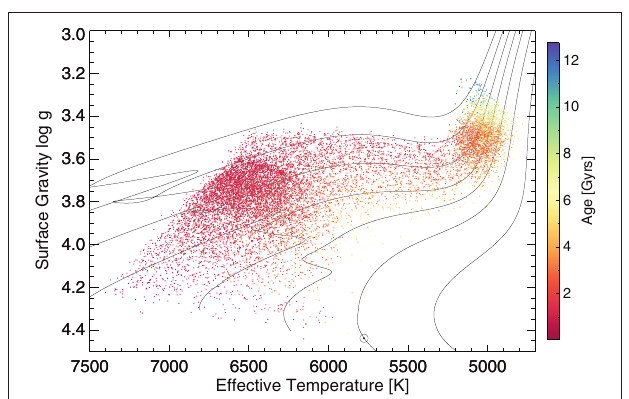
FIGURE 1 | Kiel diagram of the synthetic TESS sample of Ball et al. (2018). The age of the stars is given by the color of the dots. The Sun is indicated by its usual symbol. Evolutionary tracks for stars with masses from 0.8 to 2.0M are overlaid as solid black ⊙